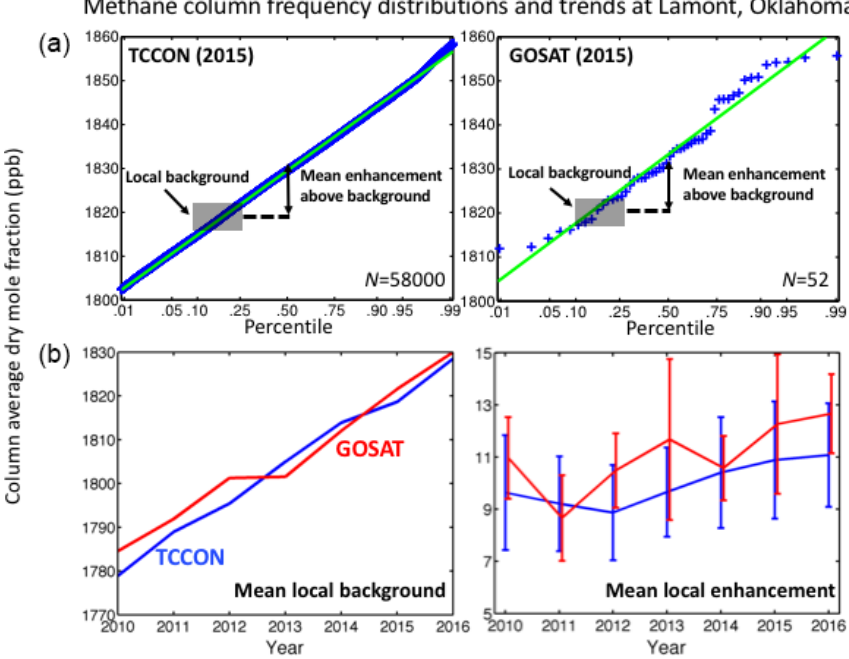
Figure 1. Frequency distributions and 2010–2016 trends of methane column average dry mole fractions X CH (36.6 ◦ N, 97.4 ◦ W), as measured by TCCON and GOSAT. The upper panels show the deseasonalized 2015 frequency distributions from TCCON and GOSAT. The percentiles (blue plus signs) are plotted on a normal probability scale such that a normal distribution would plot as a straight line (green). The local background is defined by the 10th–25th percentile range and the mean annual local enhancement relative to this background is defined by the difference with the mean of the distribution. Lower panels compare TCCON and GOSAT backgrounds and enhancements for 2010–2016, with error standard deviations on the enhancements as described in the